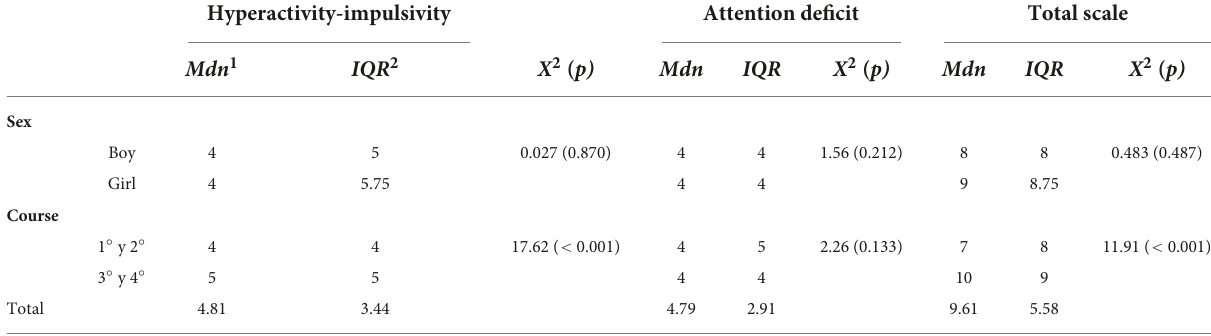
TABLE 3 Median and interquartile range of adapted EDAH scales and differences according to gender and course. Hyperactivity-impulsivity